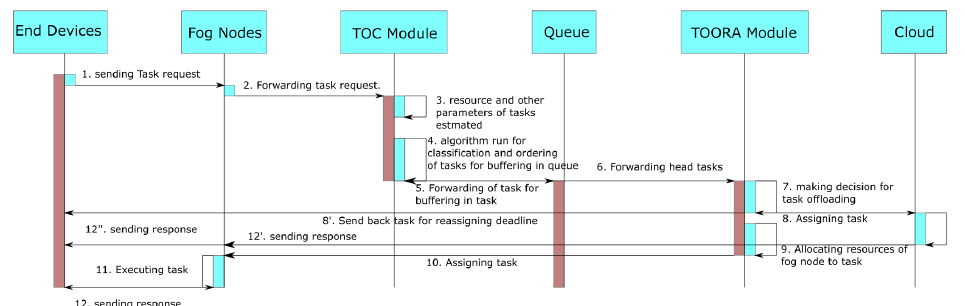
Figure 2. Process flow model of the